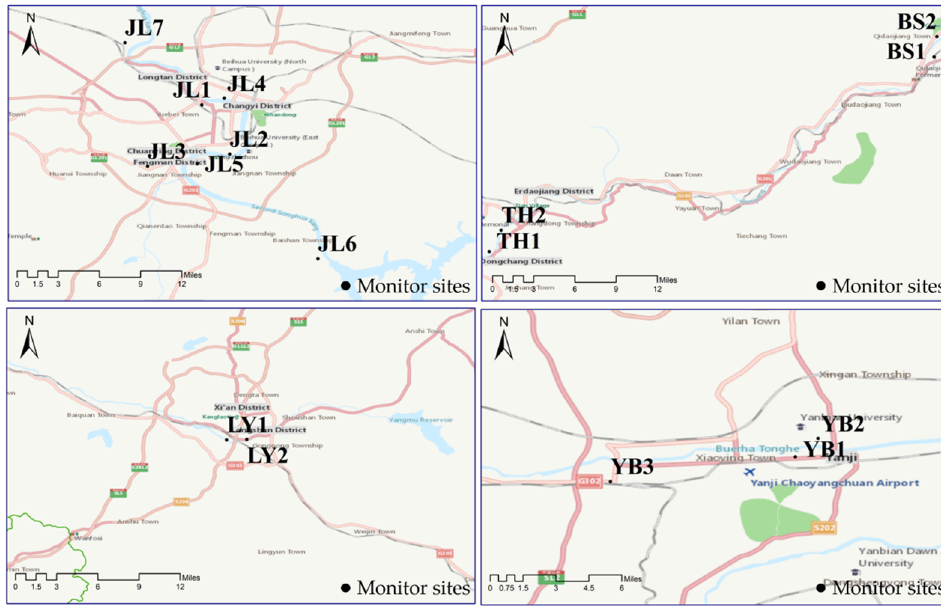
Figure 2. The specific location of monitoring stations in the east of Jilin Province.